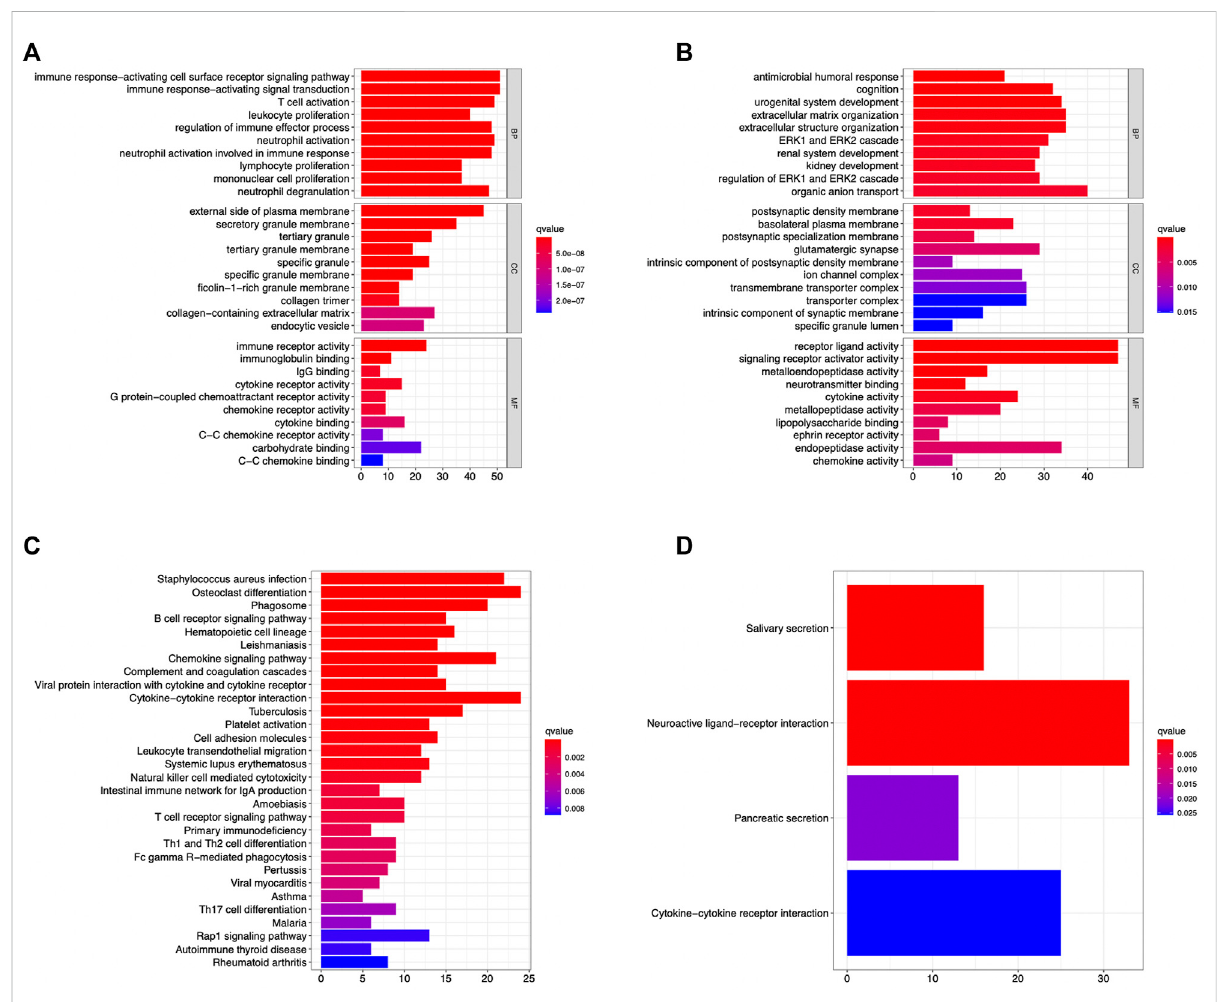
FIGURE 4 The GO enrichment and KEGG pathway enrichment analysis identi fi ed in the DEG-MEgreen (A,C) and DEG-MEturquoise (B,D) modules. The immune response and signal transduction were the main biological processes identi fi ed in DEG-MEgreen and DEG-MEturquoise, respectively. The majority of pathways identi fi ed in two modules were osteoclast differentiations, cytokine – cytokine receptor interactions, and neuroactive ligand – receptor interactions,